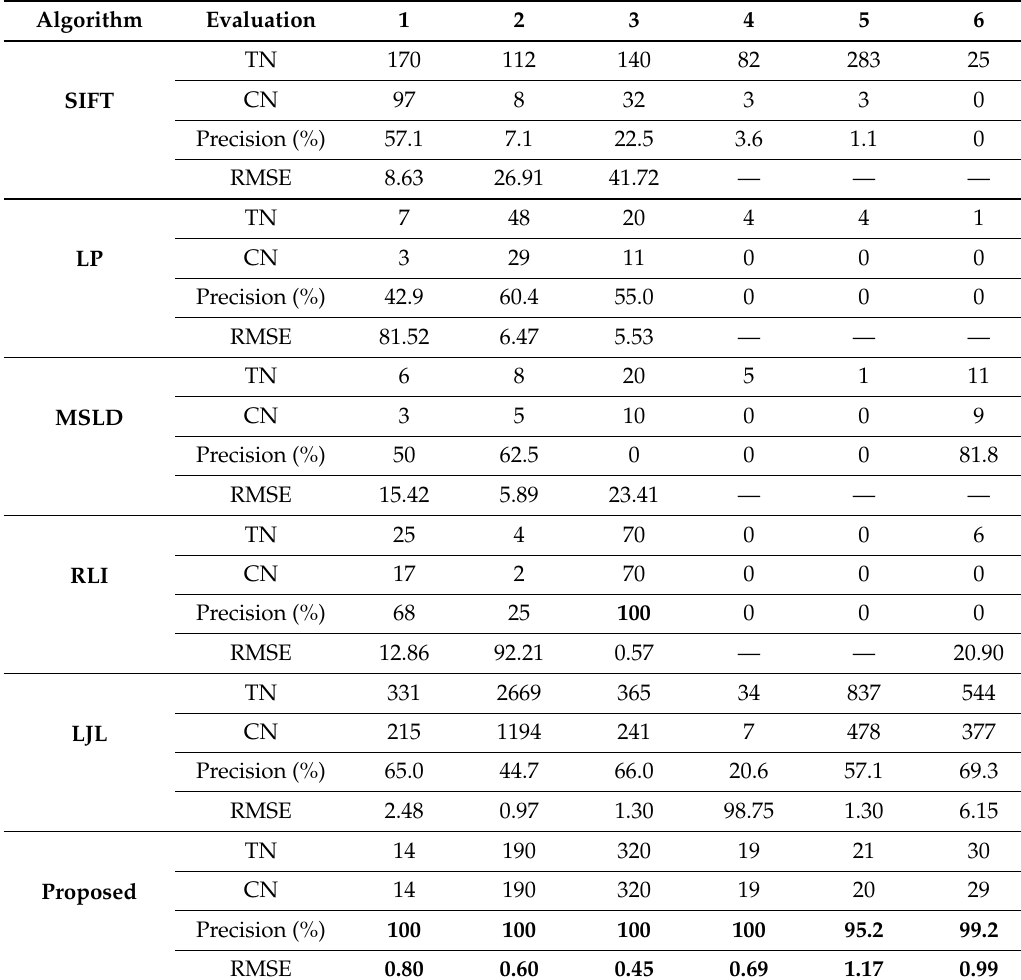
Table 5. Comparison of registration results on real remote sensing